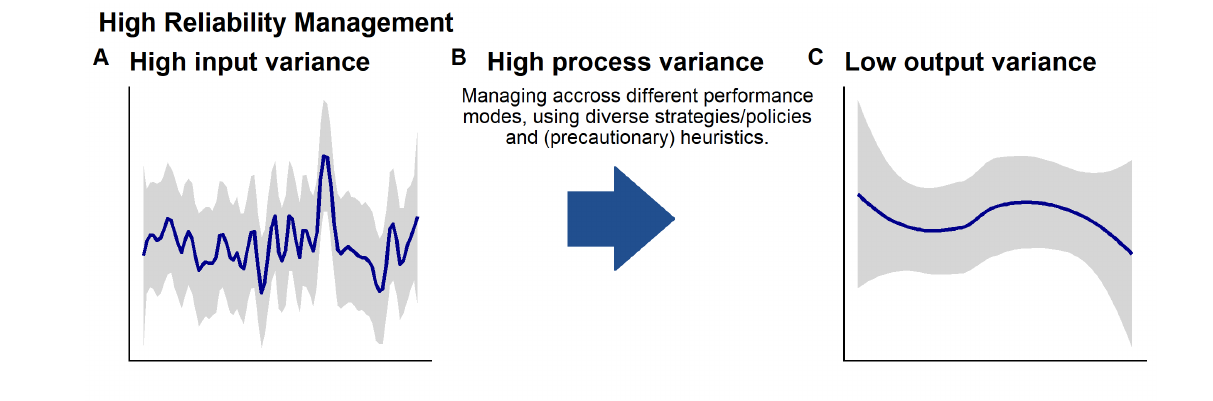
Fig. 1 . Today’s high reliability management of infrastructures, in terms of input (A), process (B), and output (C) variance.